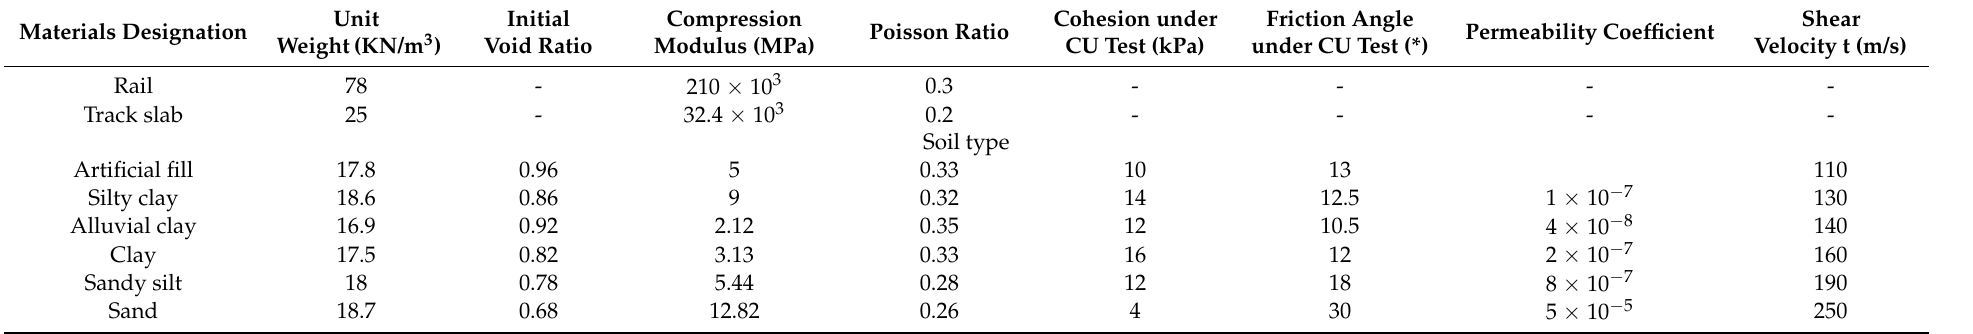
Table 1. Mechanical properties of the ground